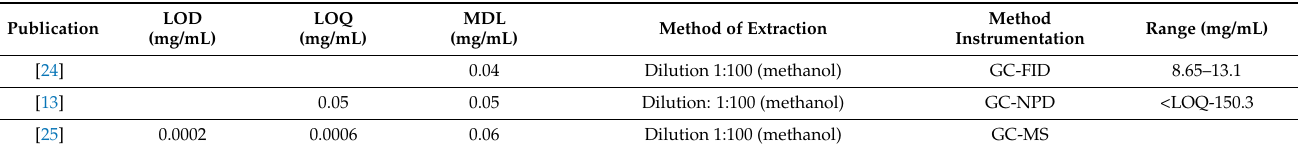
Table 4. Summary of published methods for quantification of nicotine in vaping